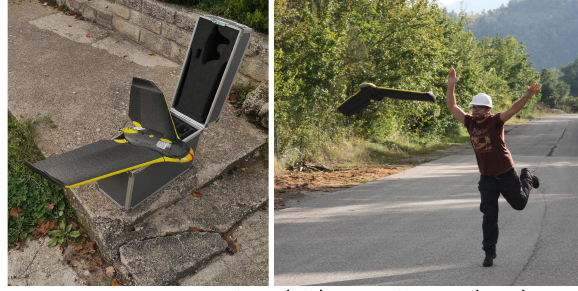
Figure 5. eBee platform (left), take-off phase (right)